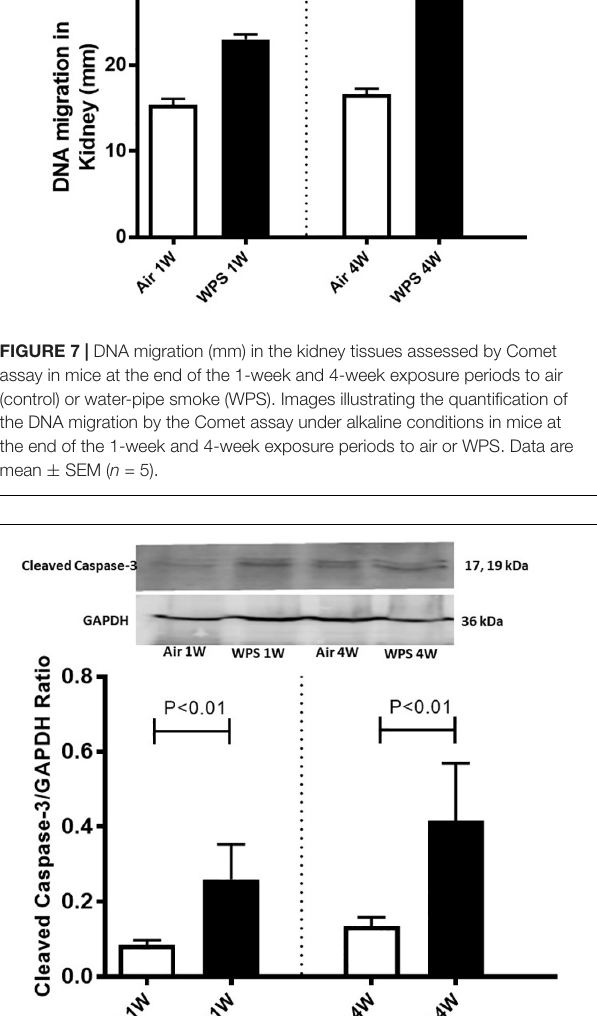
FIGURE 6 | Kidney homogenate concentrations of kidney injury molecule-1 (KIM-1, A ), interleukin-6 (IL-6, B ), and IL-1 β (C) in mice at the end of the 1-week and 4-week exposure periods to air (control) or water-pipe smoke (WPS). Data are mean ± SEM ( n = 5–8).